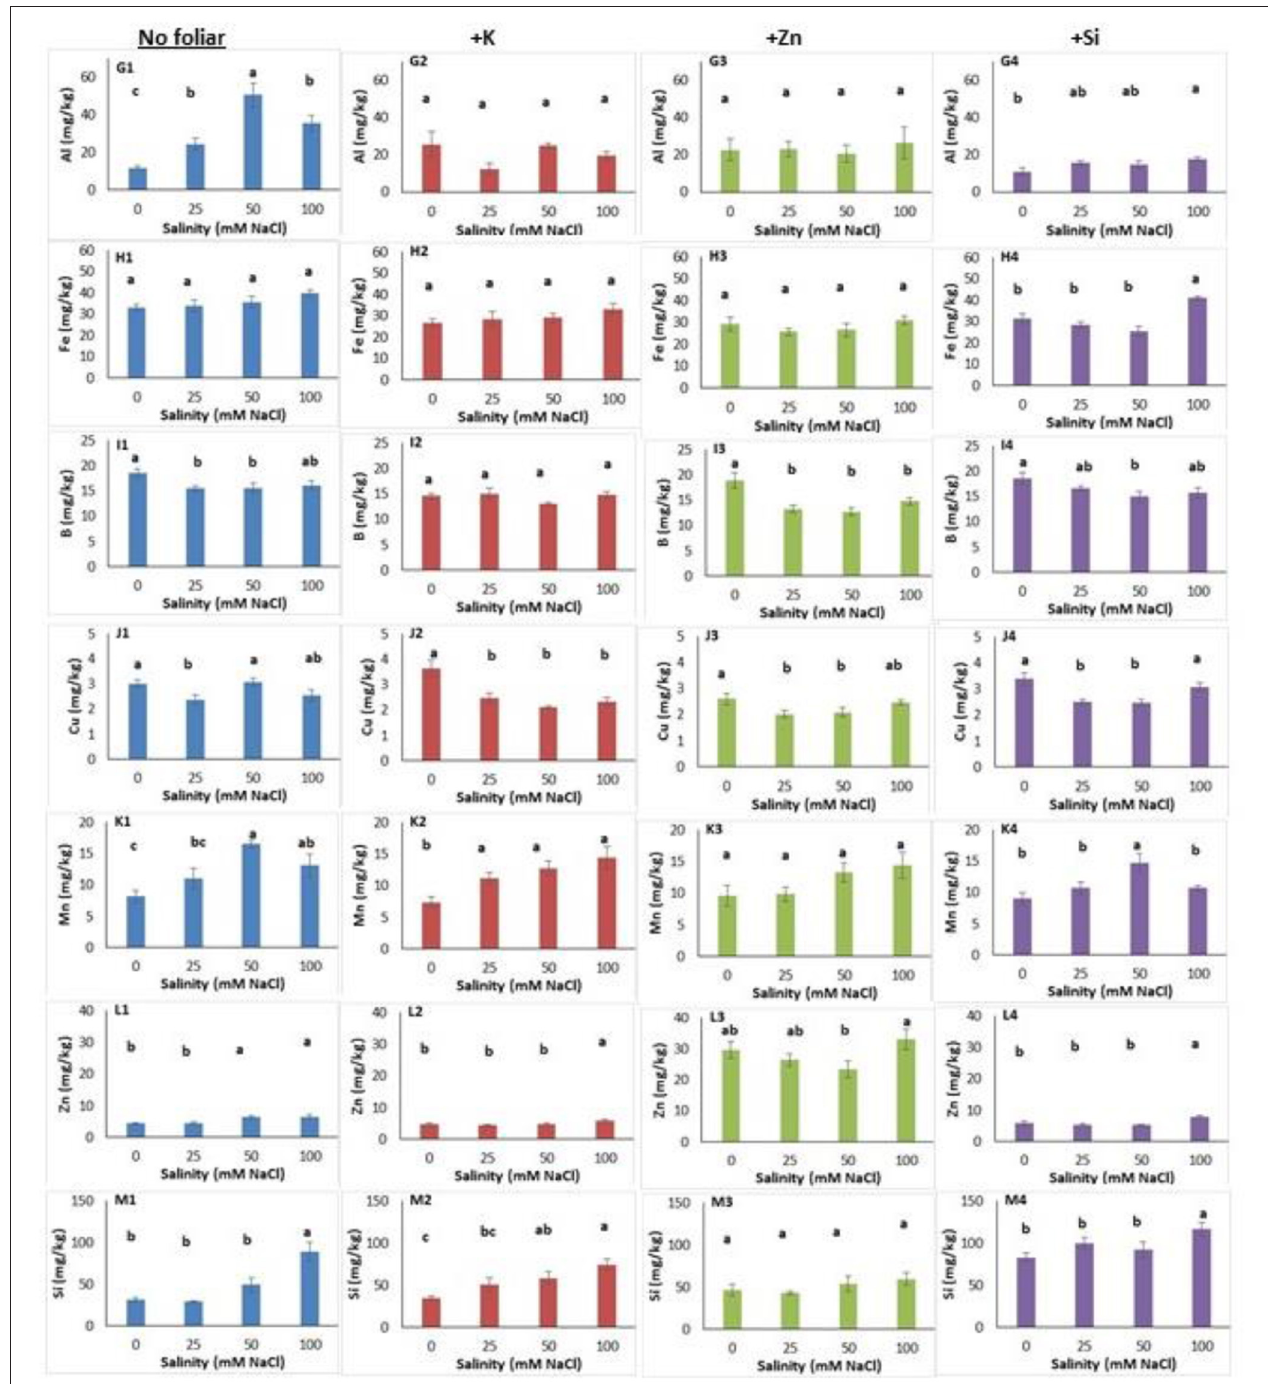
FIGURE 4 | Lavender leaf analysis (micronutrient) of plants grown hydroponically in perlite under different salinity levels (0–25–50–100 mM NaCl) and foliar applications (no foliar, K, Zn and Si). Sub-figures (G–M) referring to different micronutrients and numbering (1–4) referring to the no foliar, K, Zn and Si, respectively. Significant differences ( P < 0.05) among treatments are indicated by different letters. Error bars show SE ( n = 6).